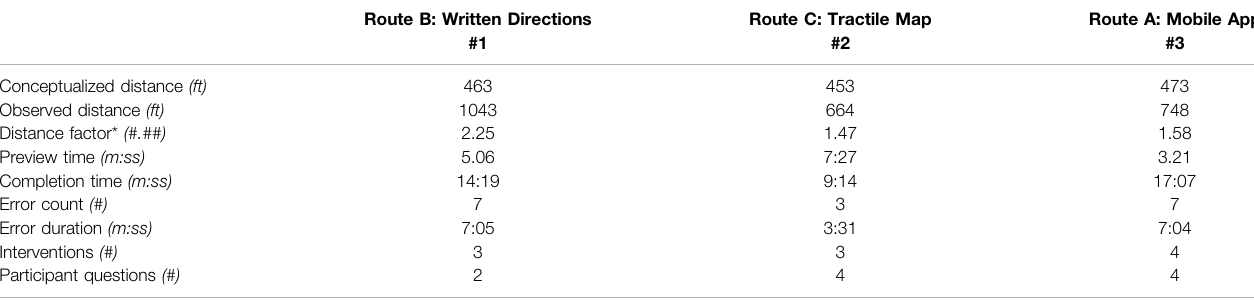
TABLE2| Routeperformancemeasuresoftheobservedway fi ndingbehaviorofourcasestudyparticipantforthethreeroutes.Allobservedrouteswereconsiderablylonger than those that we conceptualized, as conveyed by the distance factor that is provided in the table. Route B: Written Directions #1